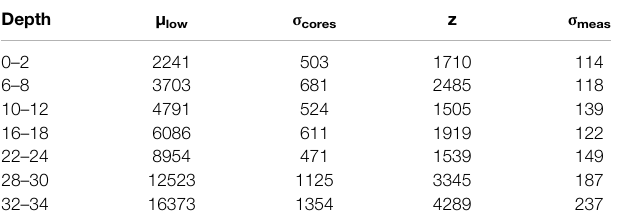
TABLE 2 | Overview of calibrated calendar ages derived from the 14 C measurements of the low-resolution bulk samples. For each depth interval (in cm), the mean age ( μ lowres ), the standard deviation ( σ cores ), the total range ( z = max age − min age ) as well as the mean measurement error ( σ meas ) of all twelve subcores (see Table 1 ) are given in years. For the layer from 32 to 34 cm, the